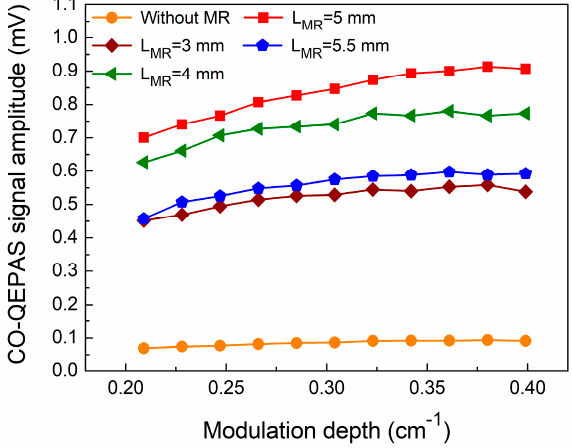
Figure 4. CO-QEPAS signal amplitude as a function of modulation depth.